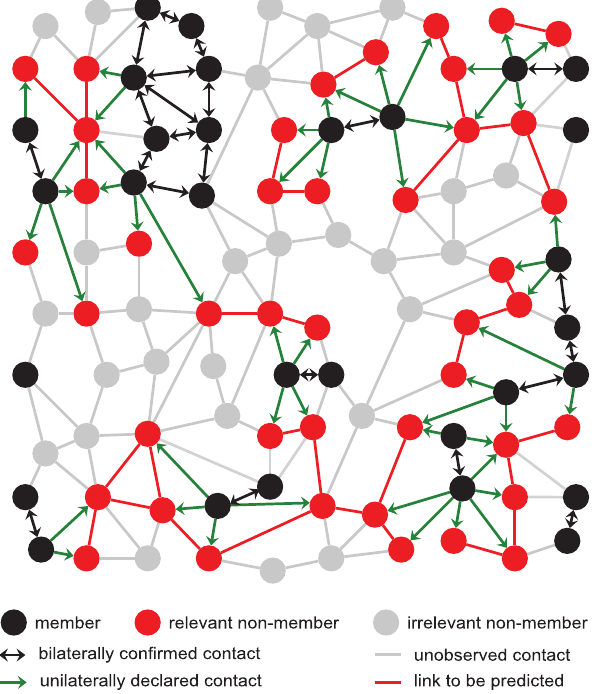
Figure 1. Definitions and examples. Any social network platform divides society into two sets: the set of members M (black nodes) and of non-members M . In our toy example 30 of 100 individuals, i.e. a fraction of r ~ 0 : 3 , are members. The relevant subset M R of non- members (red nodes) that are in contact with at least one member is distinguished from other non-members (gray nodes). 15 of the 30 members, i.e., a fraction of a ~ 0 : 5 , have disclosed their outside social contacts. The knowledge of the set of edges E I between members (black, bi-directed) and the set of edges E B (green) to non-members is enough to infer a substantial fraction of edges between non-members (red edges).